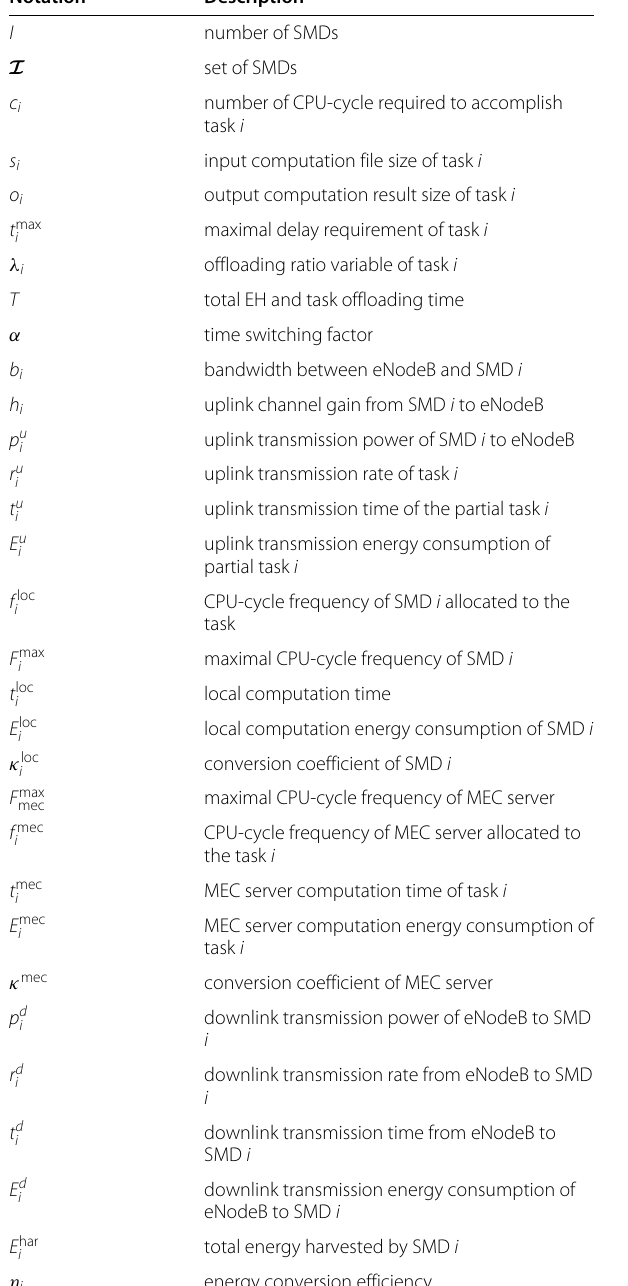
Table 1 Summary of key